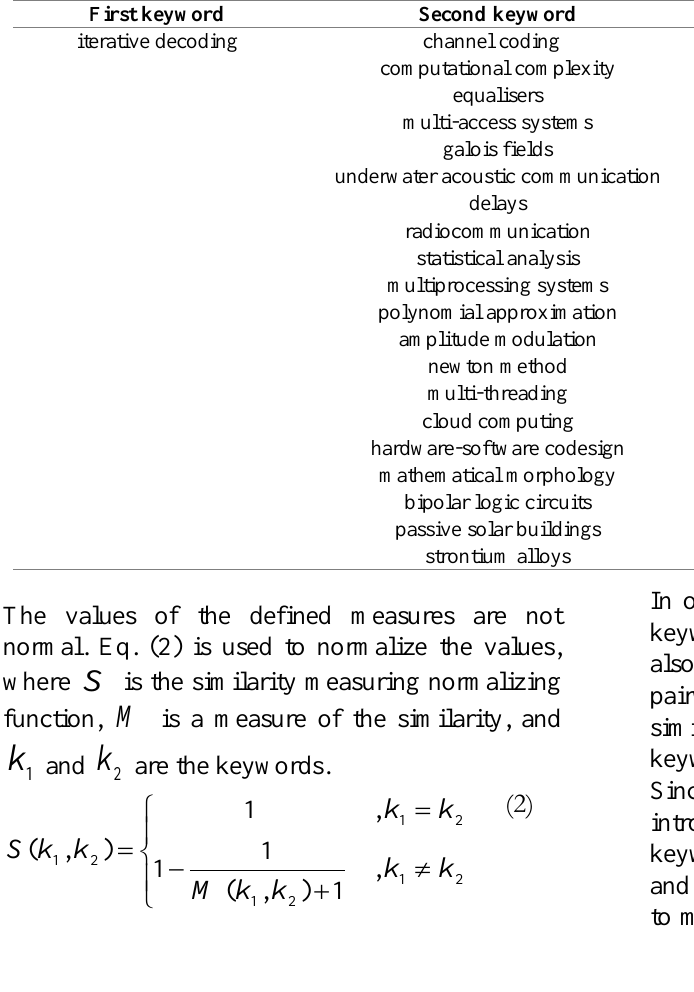
Table 2. Values of the similarity measures with a duration of two years for a few keyword